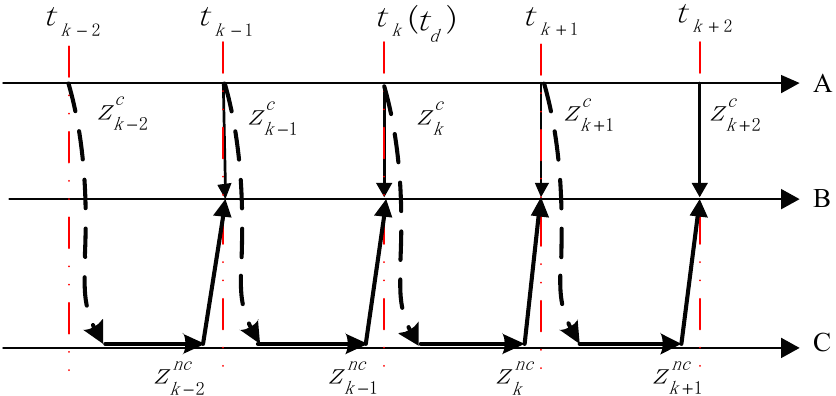
Figure 3. The measurement message passing of system: ( A ): the measurement time of binocular vision; ( B ): the measurement time of fusion; ( C ): the measurement of laser ranging sensor. The measured value z c is obtained by the binocular vision sensor at time t k − 1 . Then,